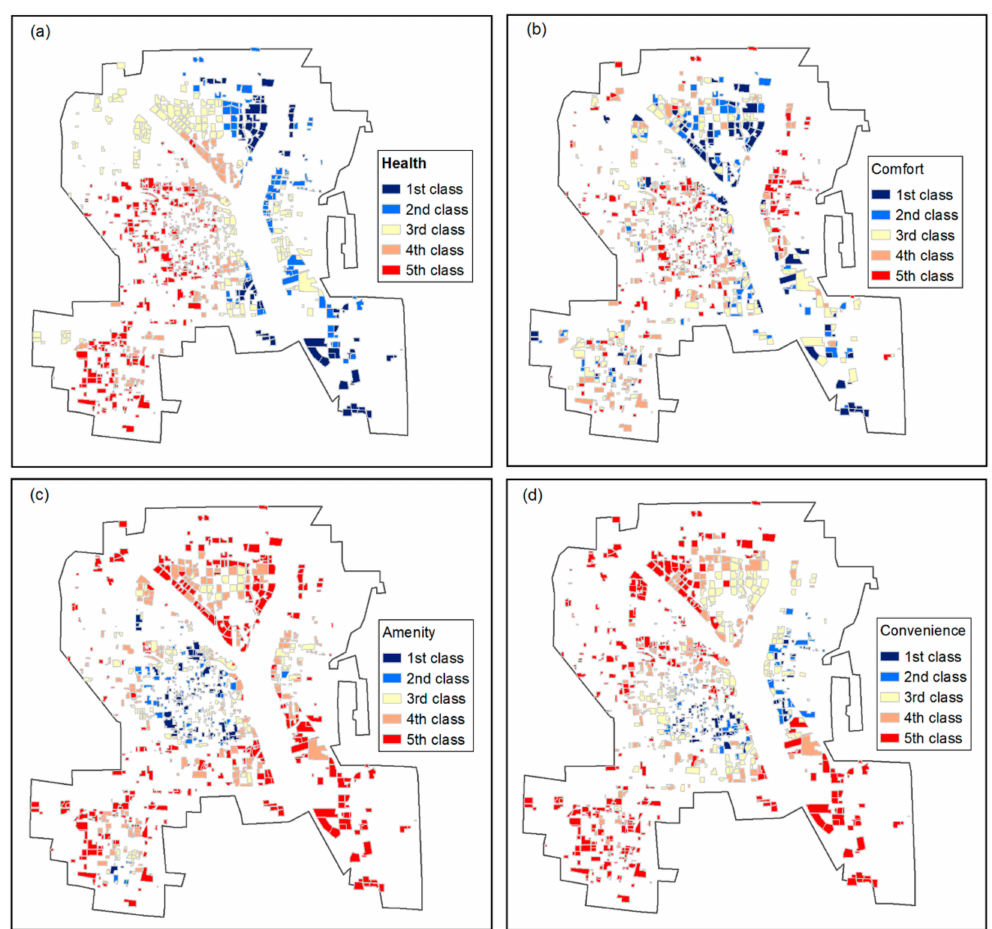
Figure 7. Livability assessment by dimension. ( a ) Environmental health; ( b ) Environmental comfort; ( c ) Living amenity; ( d ) Travel convenience. The communities of the first class were the ones whose scores were above 90th percentile, the second-class communities were the ones whose scores were within the range of the 81st and the 90th percentile, the third-class communities were the ones whose scores were within the range of the 61st and the 80th percentile, the fourth-class communities were the ones whose scores were within the range of the 41st and the 60th percentile, and the fifth-class communities were the ones whose scores were below the 40th